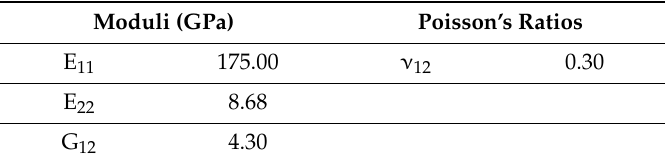
Table 1. Material properties of CYCOM 977-2.